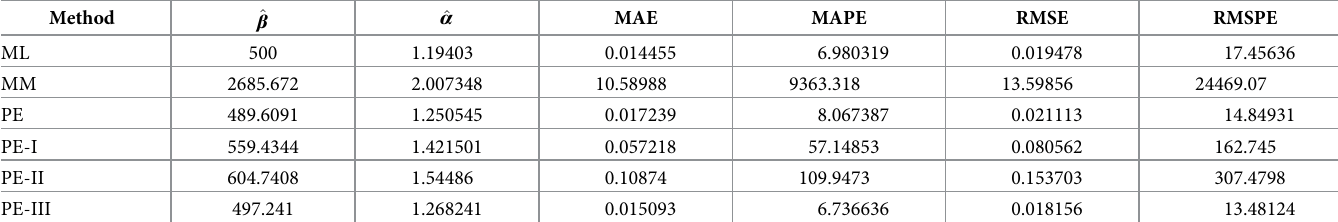
Table 6. Comparison of estimators for example